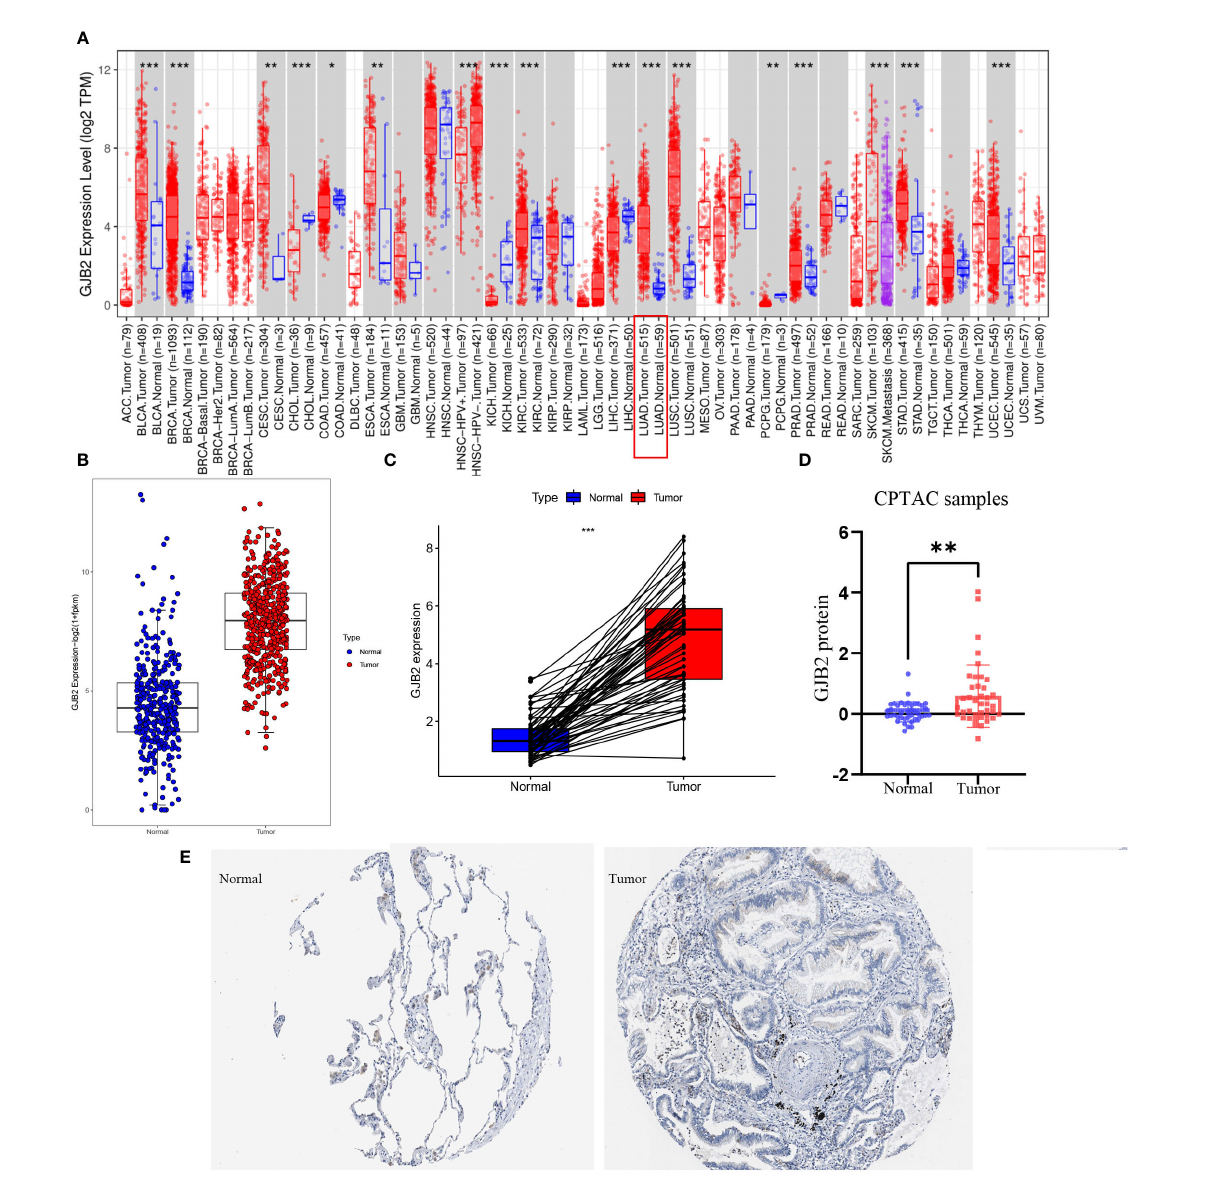
FIGURE 1 GJB2 was upregulated in LUAD. (A) GJB2 expression levels in diverse kinds of tumors. Data was extracted from the TCGA database by TIMER. (B) GJB2 expression in LUAD tissues compared to that in nonmalignant lung tissues. (C) GJB2 expression pre-disease and post-disease in the same patient. (D) Differential expression of GJB2 protein between LUAD and nonmalignant lung tissues in the CPTAC data resource. (E) GJB2 immunochemistry in LUAD and normal tissue using data from HPA. *P<0.05, **P<0.01,